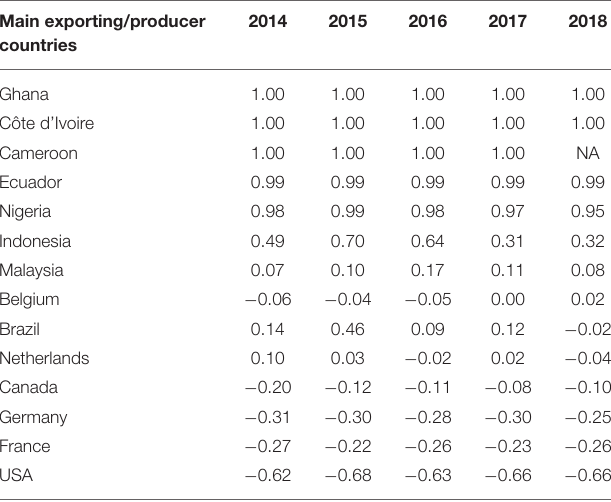
TABLE 4 | Development of Trade Spesialization Index (TSI) values in major cocoa exporting / producing countries, 2014–2018. Main exporting/producer